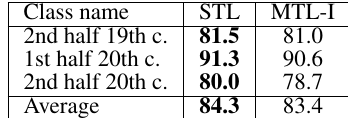
Table 7. F1-Scores [%] for the task production timespan (second series of experiments).